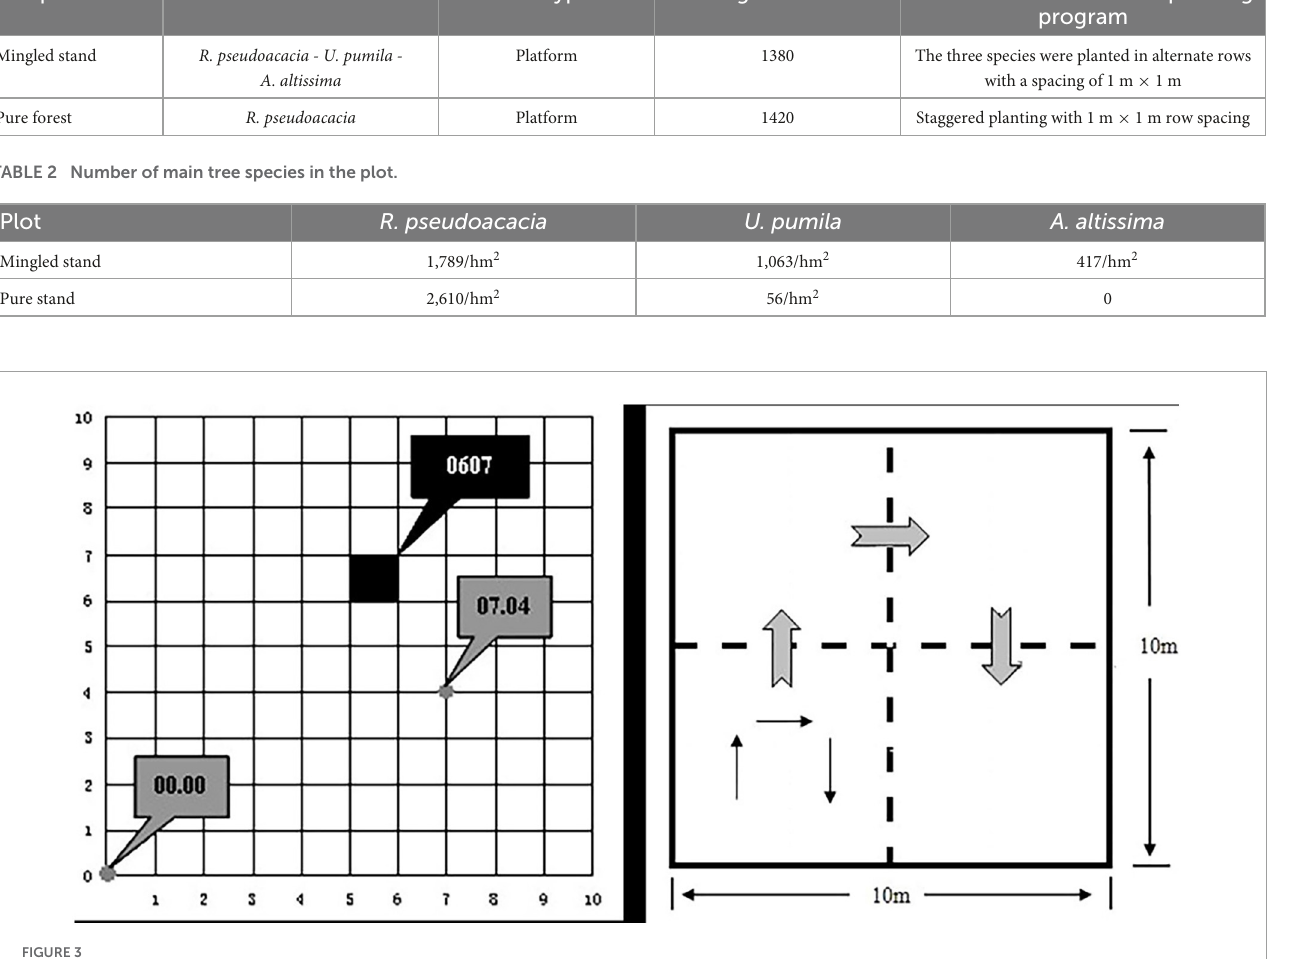
using SPSS 20.0, ANOVA was used to analyze the significance of differences in growth rates of different pairs of R. pseudoacacia , and the significance of differences test with Bonferroni ( p <